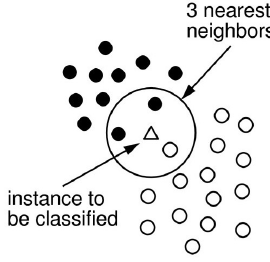
Figure 7. Three nearest neighbors of an instance to be